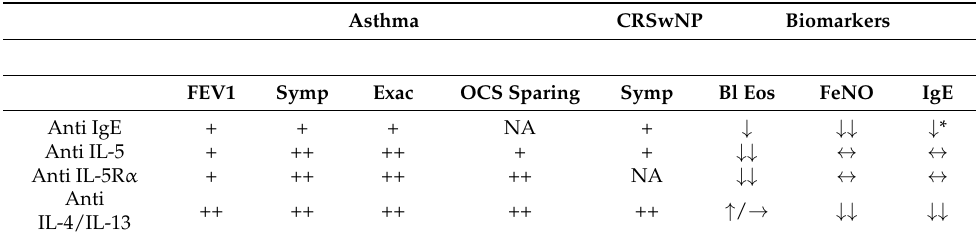
Table 1. Effects of biologic therapies in asthma and nasal